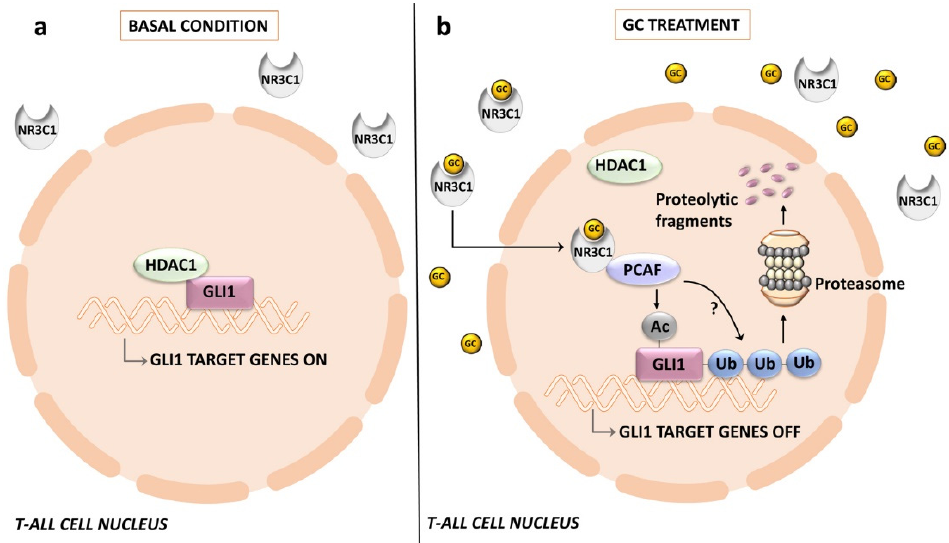
Figure 6. Crosstalk between HH signaling and the glucocorticoid receptor NR3C1 in T-ALL cells: ( a ) in the absence of glucocorticoids, GLI1 is associated with HDAC1 and transcription of GLI1- regulated genes is active; ( b ) upon treatment with glucocorticoids, NR3C1 translocates to the nucleus, thereby displacing HDAC1 and facilitating association of the histone acetylase PCAF with GLI1. PCAF acetylates GLI1, which is then targeted for proteasomal degradation. GC, glucocorticoids; HDAC1, histone deacetylase 1; NR3C1, nuclear receptor subfamily 3 group C member 1; PCAF, p300/CBP-associated factor.